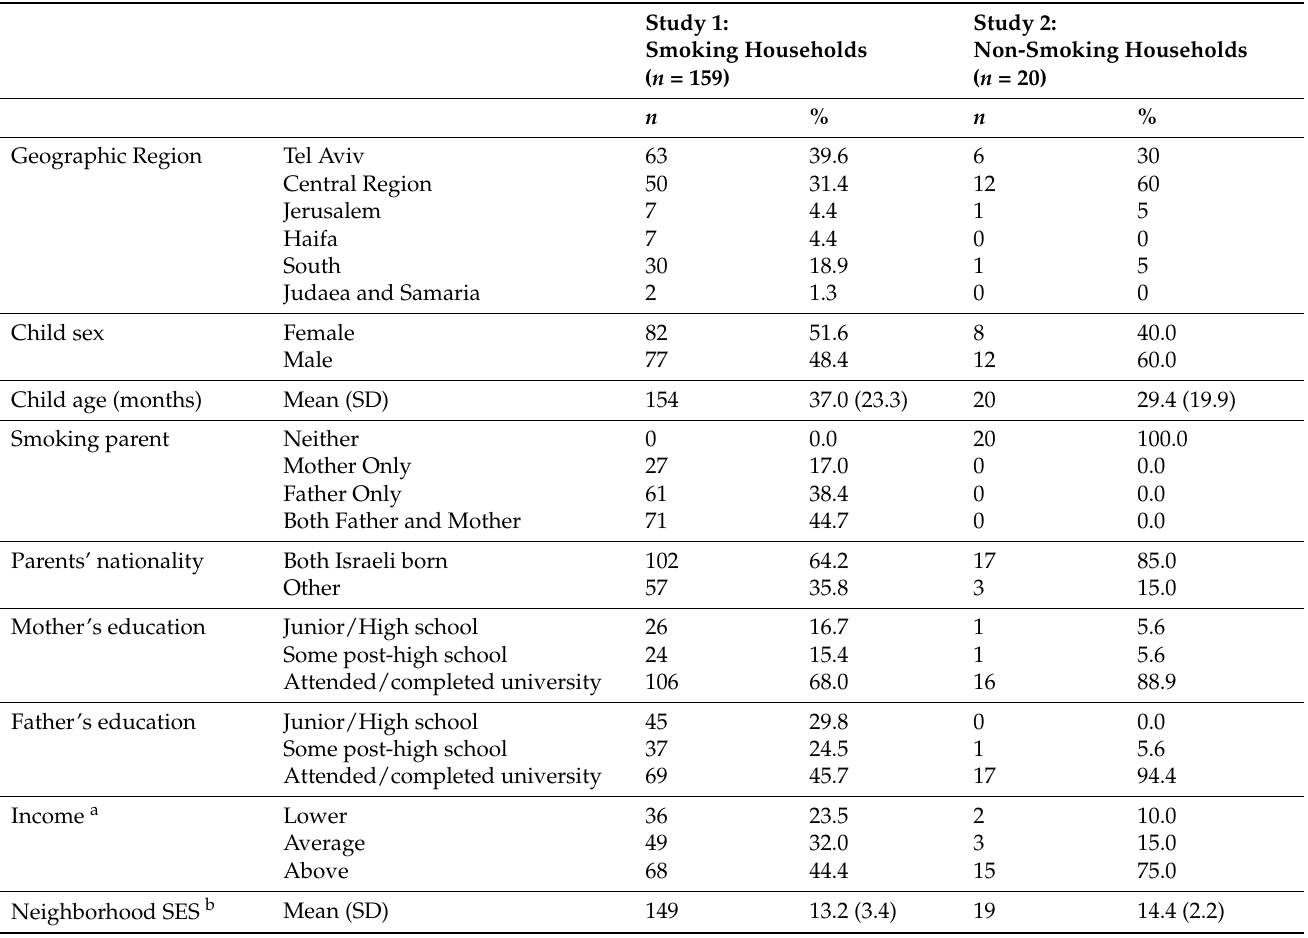
Table 1. Sample characteristics of participating